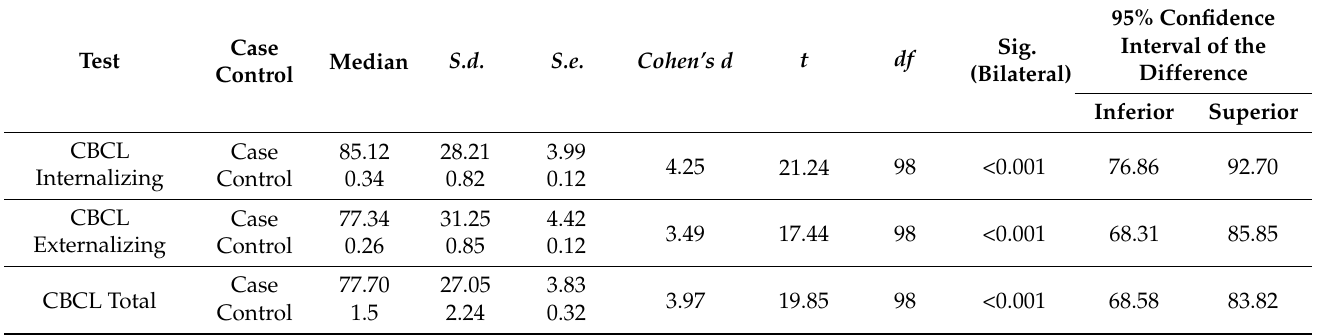
Table 4. Comparison of mental health problems (CBCL) between cases and controls ( n cases = 50, n controls =